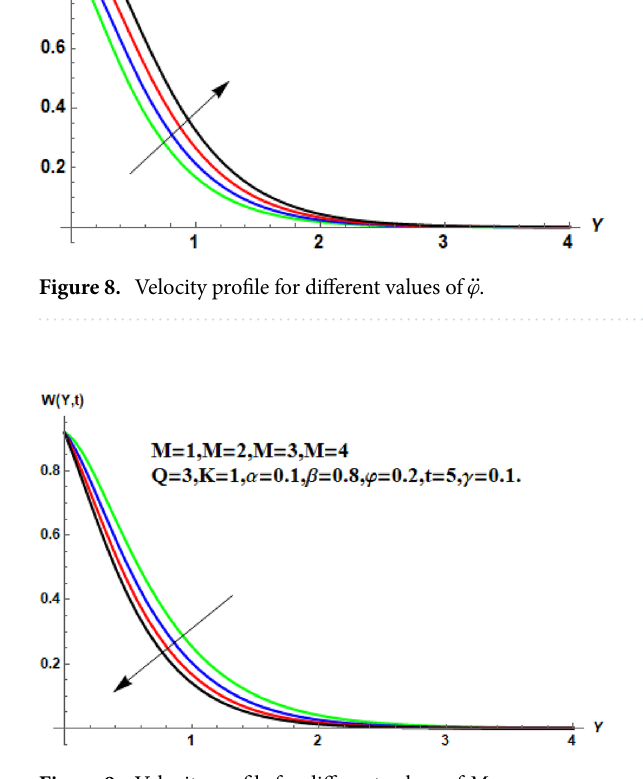
Figure 9. Velocity profile for different values of M .